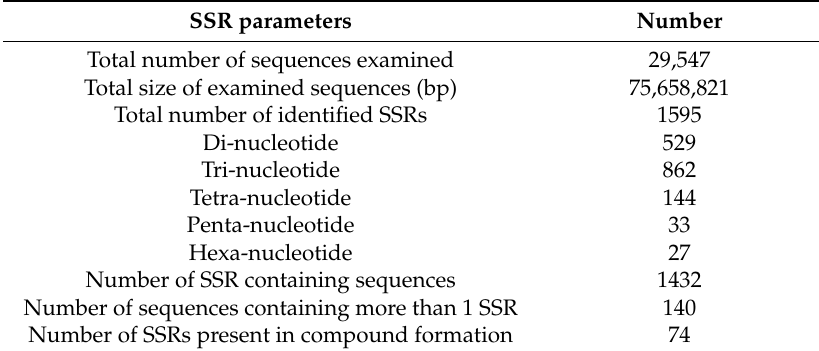
Table 3. SSRs identified from the unigene sequences of T. longicaudatus .